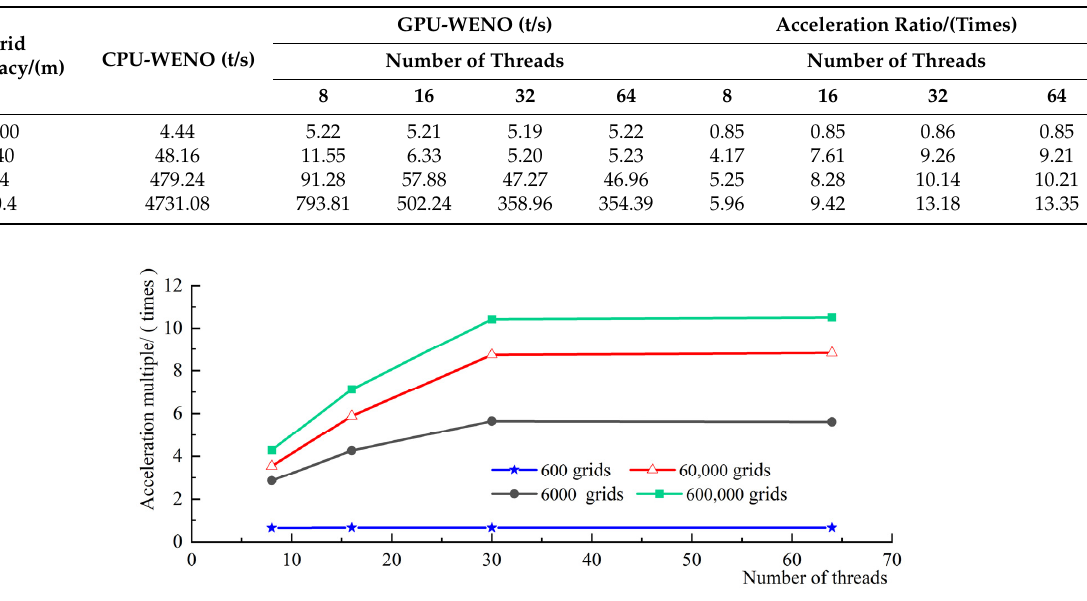
Figure 12. Accelerated rendering with different threads and grid numbers in